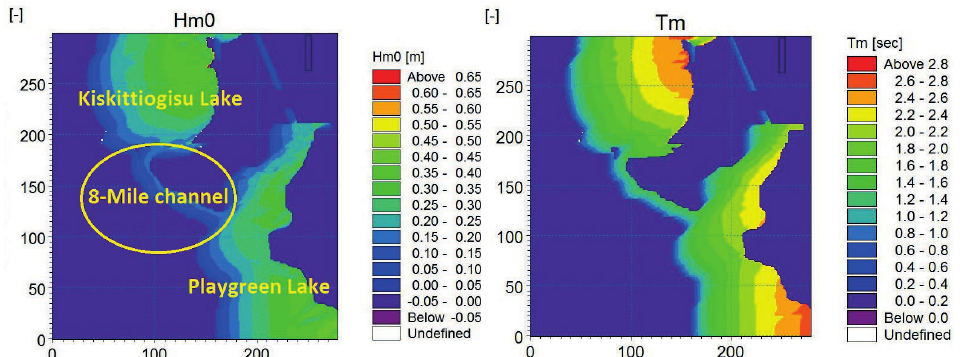
Fig. 6 Significant wave height and wave period in 8-Mile channel (MIKE 21 NSW).